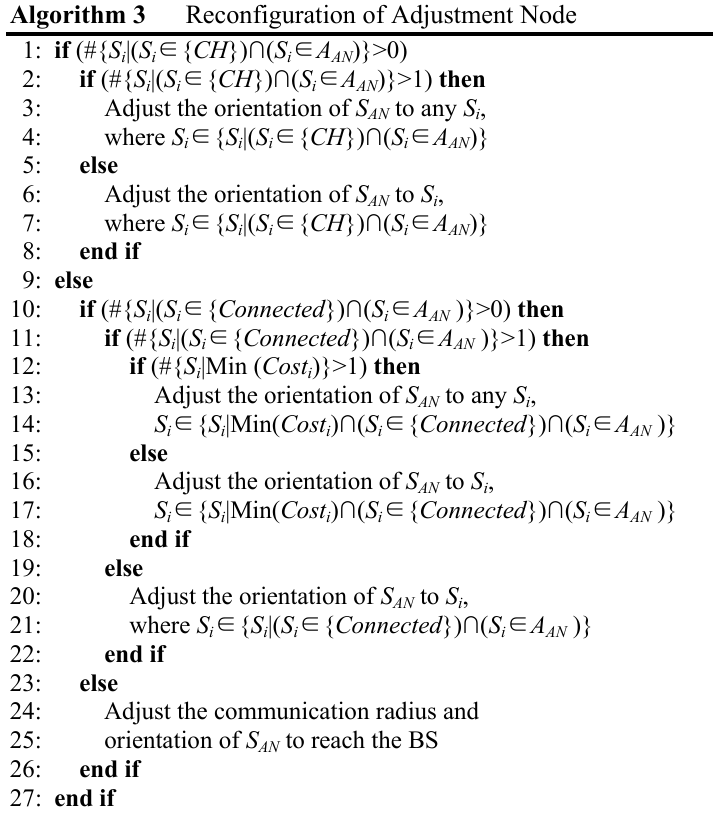
Figure 7. Reconfiguration of adjustment